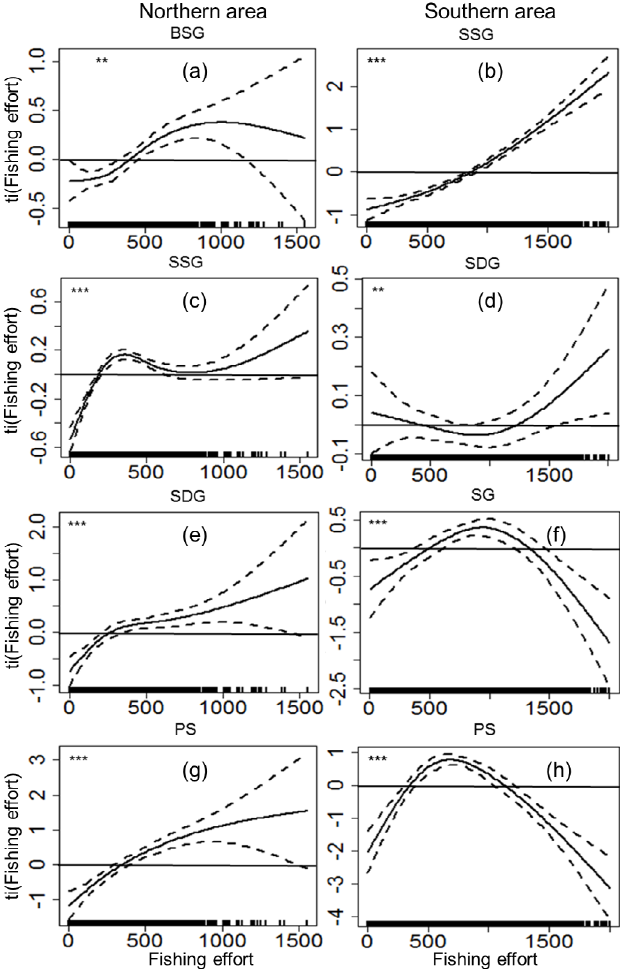
Fig. 5. Estimated smooth curves obtained by the GAM applied to landings of Sardinella maderensis in the northern area ( fi rst column) and the southern area (second column): bottom set gillnet (BSG, a); surface-set gillnet (SSG, b and c); surface-drift gillnet (SDG, d and e); surrounding gillnet (SG, f) and purse seine (PS, g and h). Dashed lines represent two standard error boundaries around the covariate main effects. Signi fi cance codes: (cid:1)(cid:1)(cid:1) 0.001; (cid:1)(cid:1) 0.01; (cid:1) 0.05. The x -axis shows the density of points for each covariate and the y -axis re fl ects the relative importance of each